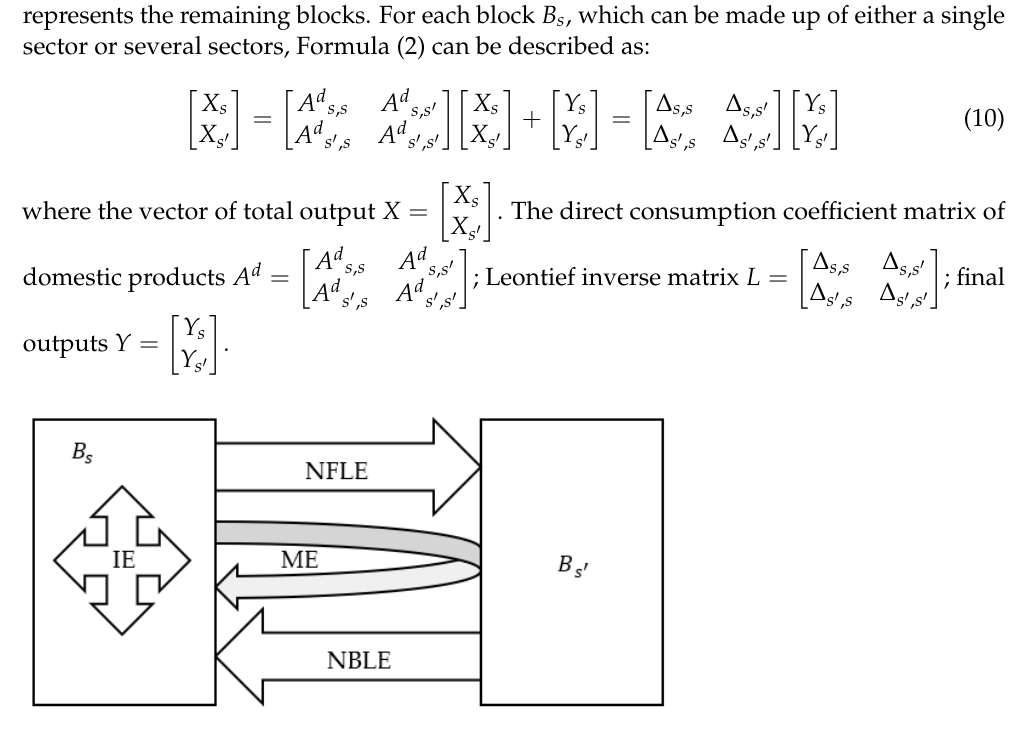
Figure 1. Analysis of air pollutant emission linkages. (IE: internal emission; ME: mixed emission; NBLE: net backward linkage emission; NFLE: net forward linkage emission).